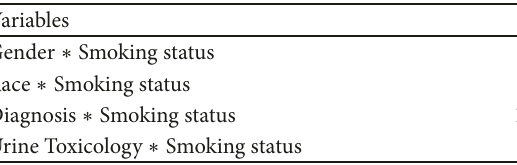
Table 4: Chi-Square analysis of selected variables and smoking